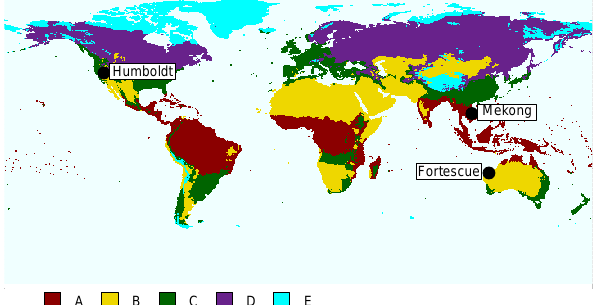
Fig. A1. Locations of the discharge gauges of the additional rivers within the 5 major climate types.